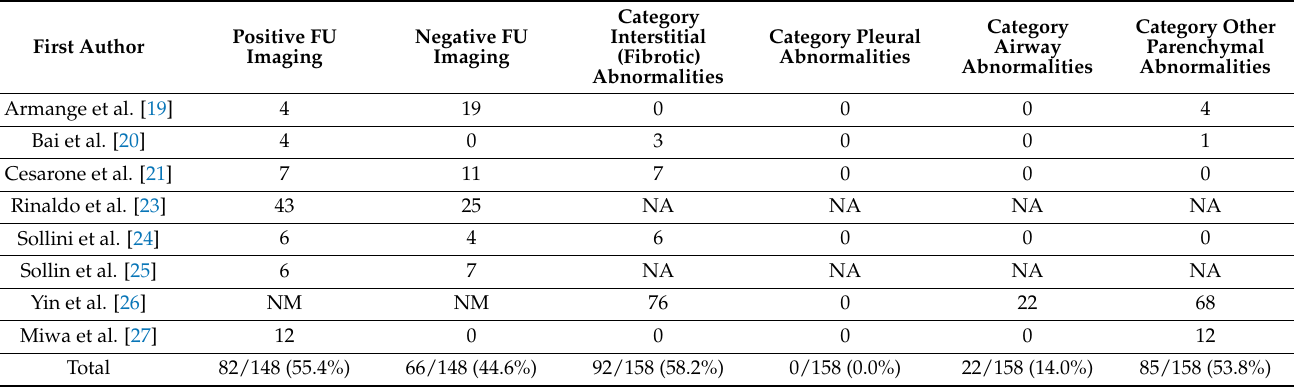
Table 5. Frequency of lung imaging abnormalities in cohort/case-control studies that were performed In FU